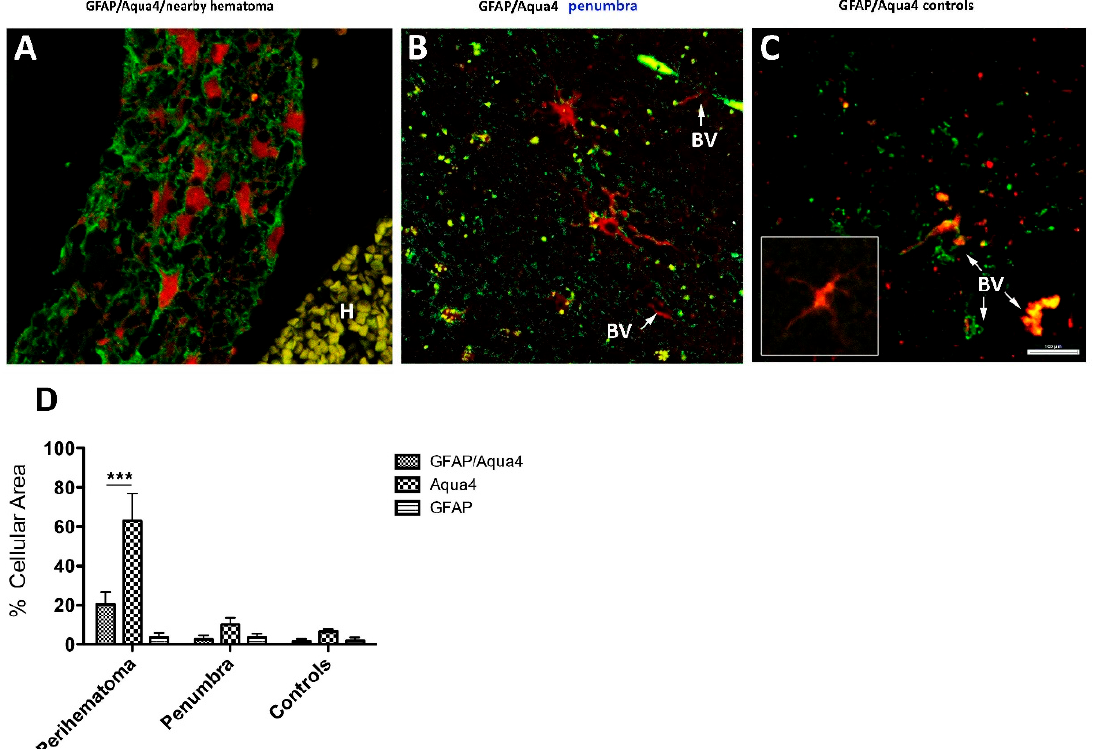
Figure 2. Glial fibrillary acidic protein (GFAP) and aquaporin 4 (AQP4) expression pattern in the perihaematomal area Many reactive astrocytes expressing AQP4 were detected in the proximity of large haematomas areas ( A ). Perihaematomal areas were populated mostly with reactive astrocytes on a background of di ff use aquaporine4 immunostaining ( B , green). In controls, astrocytes and AQP4 were codistributed on blood vessels and astrocytes having a normal morphology ( C and inset). A quantification of the cellular area covered by GFAP- and AQP4-positive cells revealed that AQP4-positive cells were predominant in the perihaematomal area, followed by colocalized GFAP / AQP4 structures ( D ). *** p = 0.001. In the figure legend, Aqua4 indicates AQP4.